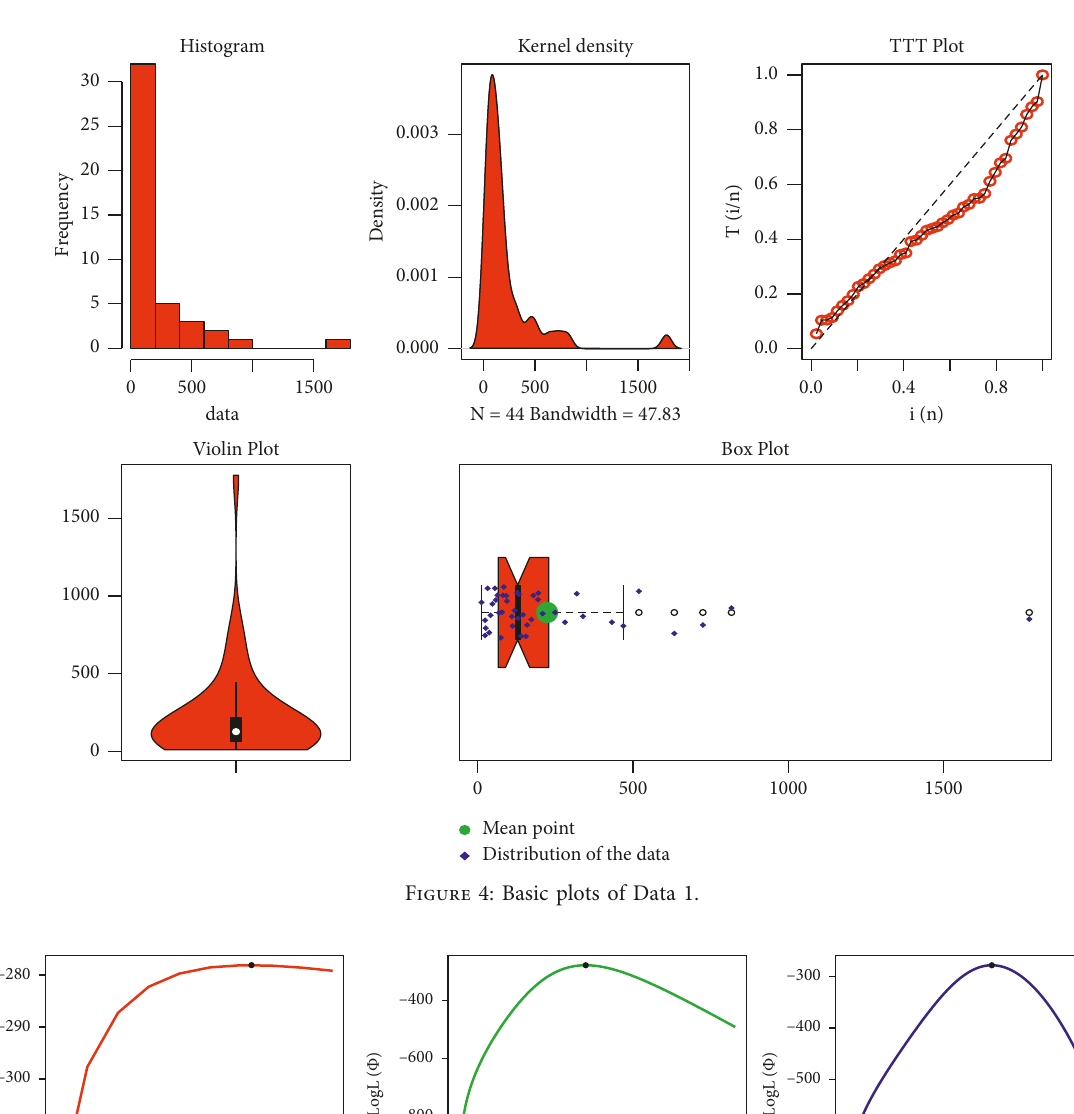
Figure 5: The profiles of the log LF of the NFLog-Wei distribution using Data 1.